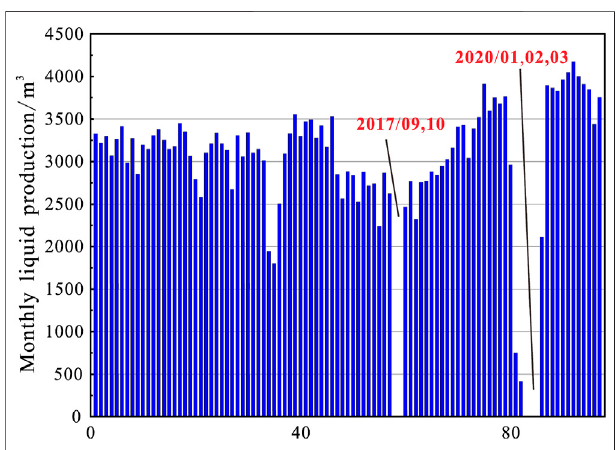
FIGURE 4 | Histogram of monthly water injection volume of